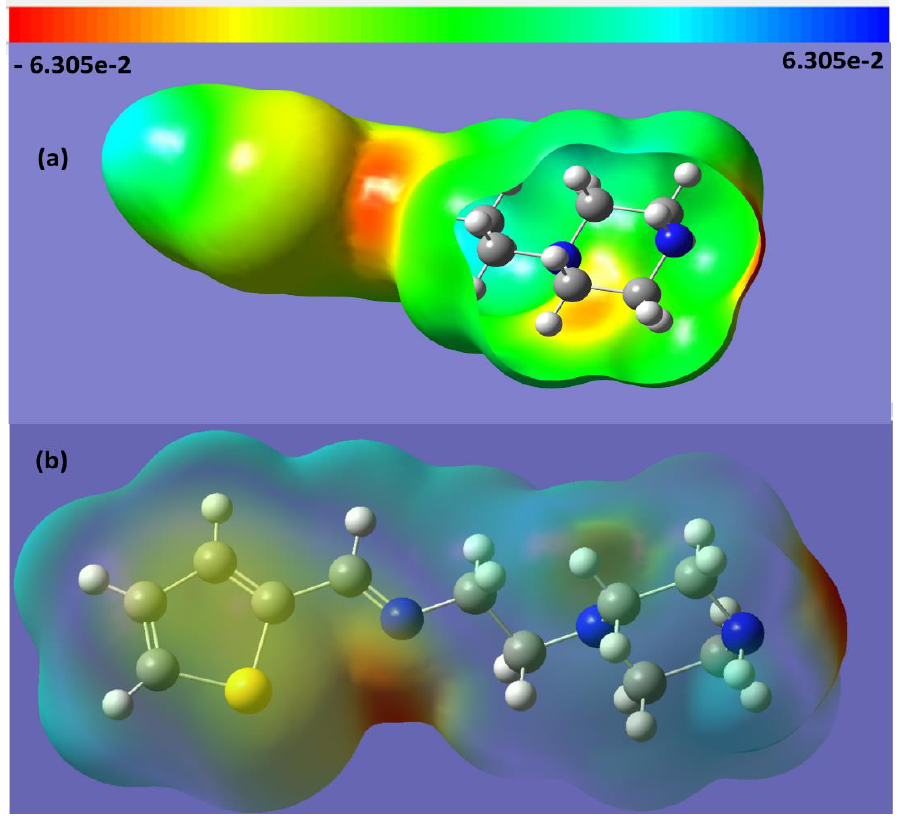
Figure 6. MEP surface of the E - L2 ligand; ( a ) parabolic vertical cut and ( b ) transparent view.